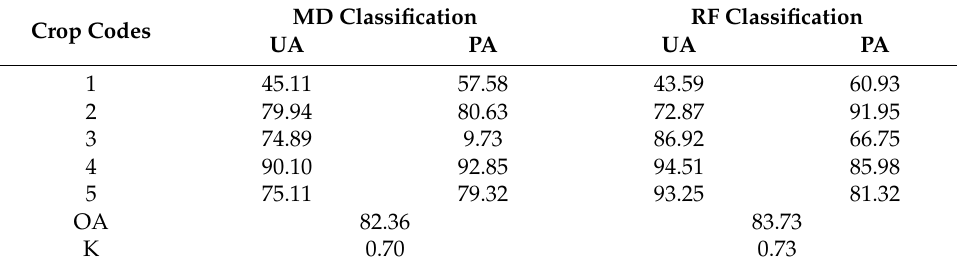
Table 12. Test separability of ROI with JM.